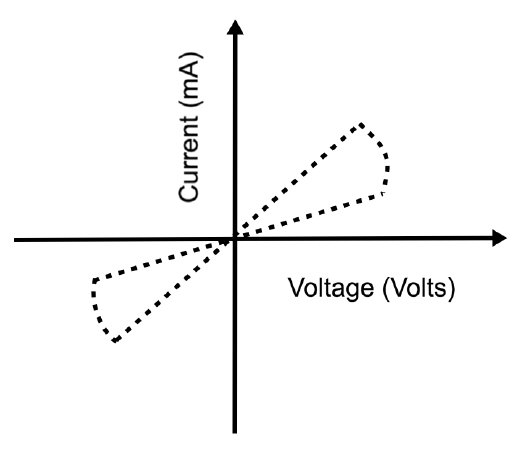
Figure A2. Bipolar and non-volatile switching pinched hysteresis.